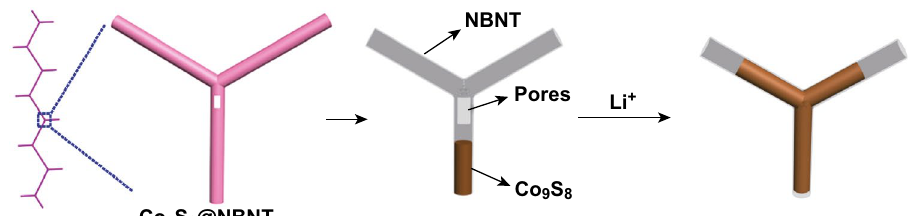
Fig. 1 Illustration of lithium‑ion storage in a Co 9 S 8 @NBNT